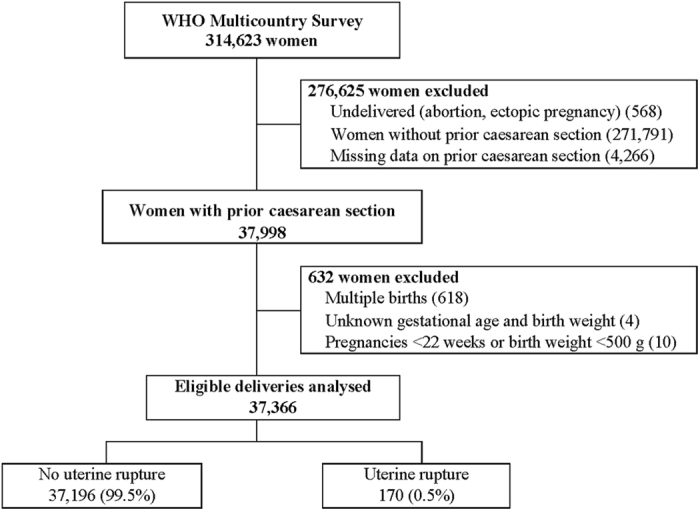
Study sample selection flow chart.